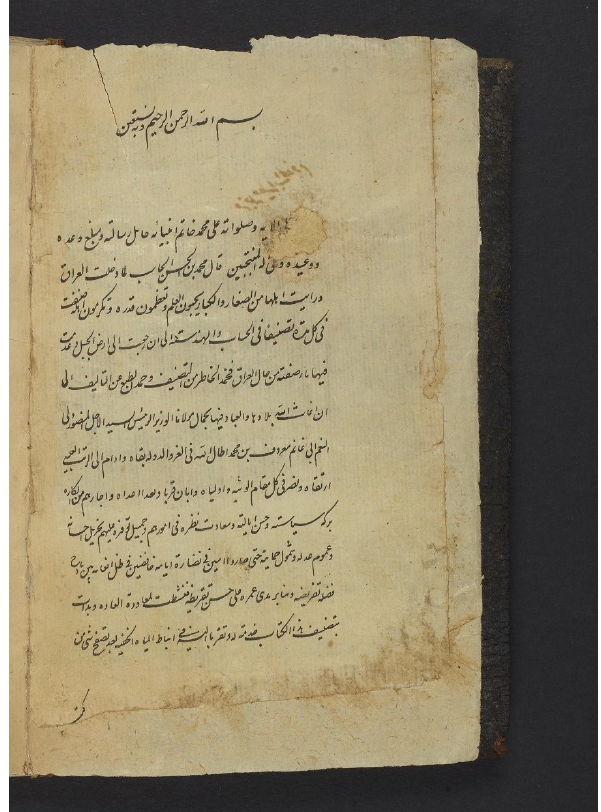
Figure 2. The first page of Inb¯at al-miy¯ah al-khafiya . Page 1v from Karaji (1675). Permanent link: http://hdl.library.upenn.edu/1017/d/ medren/9948256513503681 (last access: 29 July